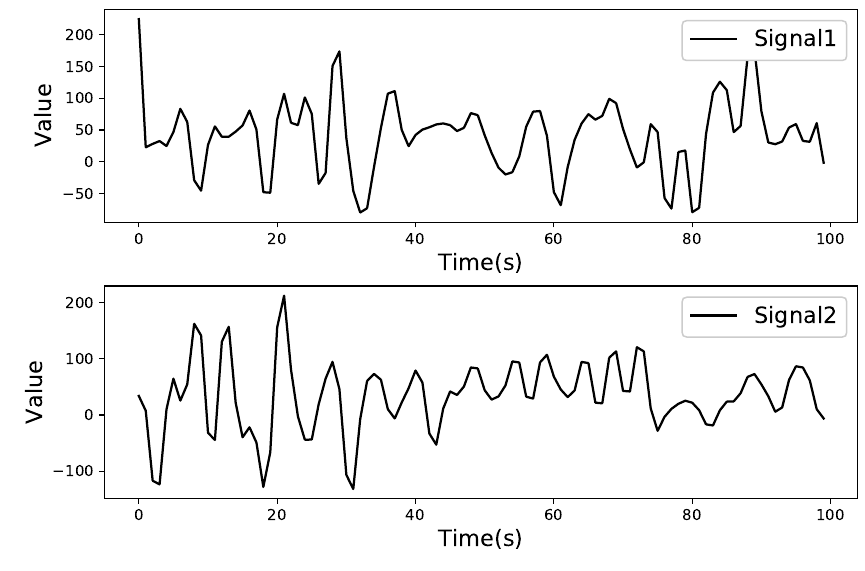
Figure 2. Example of the detail component